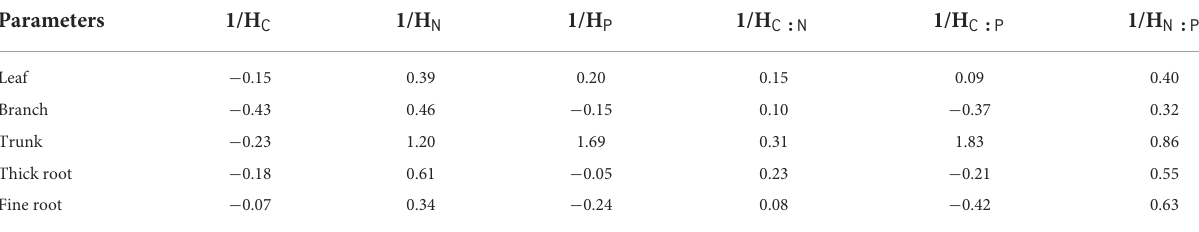
TABLE 2 Homeostasis of stoichiometry among five tissue types of Qinghai spruce.